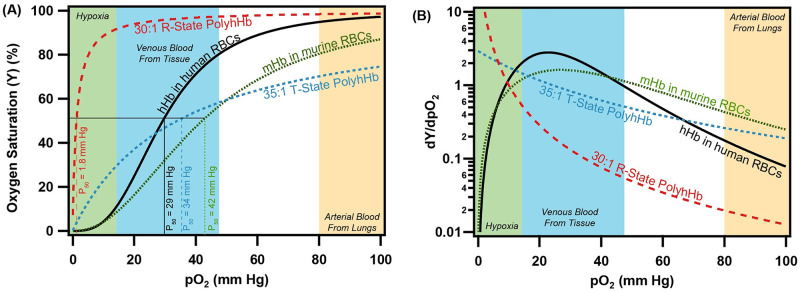
OEC and O2 offloading plot for various O2 carrying species used in the simulations.(A) The OEC is shown for human hemoglobin (hHb) in human RBCs, mouse hemoglobin (mHb) in mouse RBCs, 30:1 R-State PolyhHb, and 35:1 T-State PolyhHb. (B) The O2 offloading plot as a function of the pO2 is shown for the same species. Approximate pO2 regions for arterial and venous blood under normoxic conditions have been included on this graph for reference.